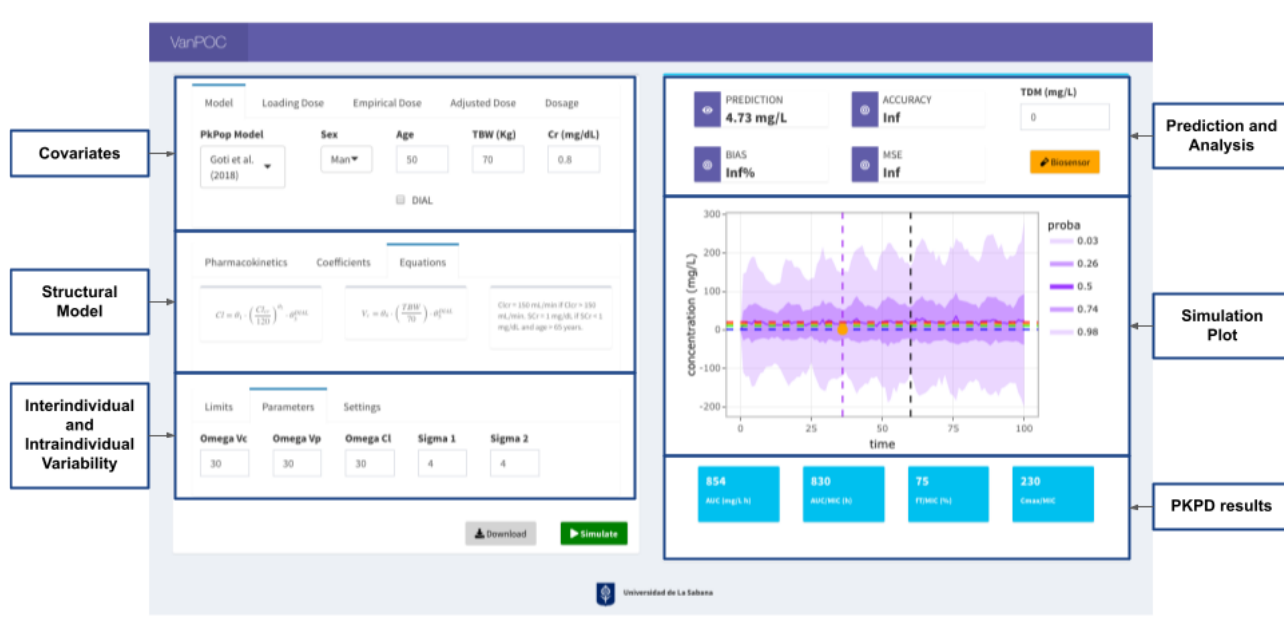
Figure 4. Design of Shiny App.